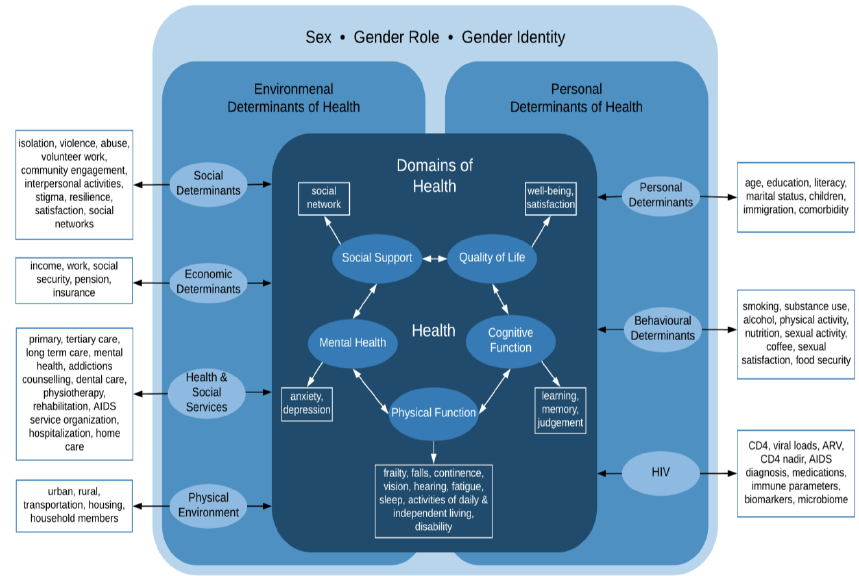
Figure 1. Conceptual model of healthy aging used in the CHANGE HIV study design.